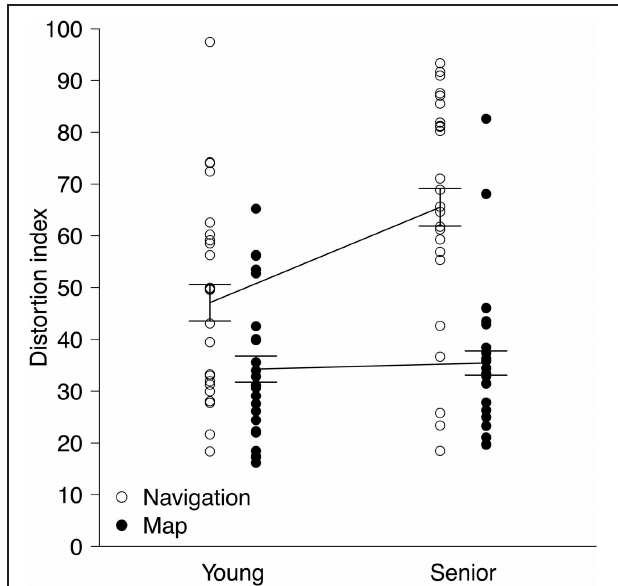
FIGURE 2 | Distortion indices (DIs) as a function of group (young vs. senior) and type of learning (navigation vs. map). Each dot shows a DI of one participant. For each type of learning, a solid line connects the means of the age groups. Error bars represent ± 1 standard error of the